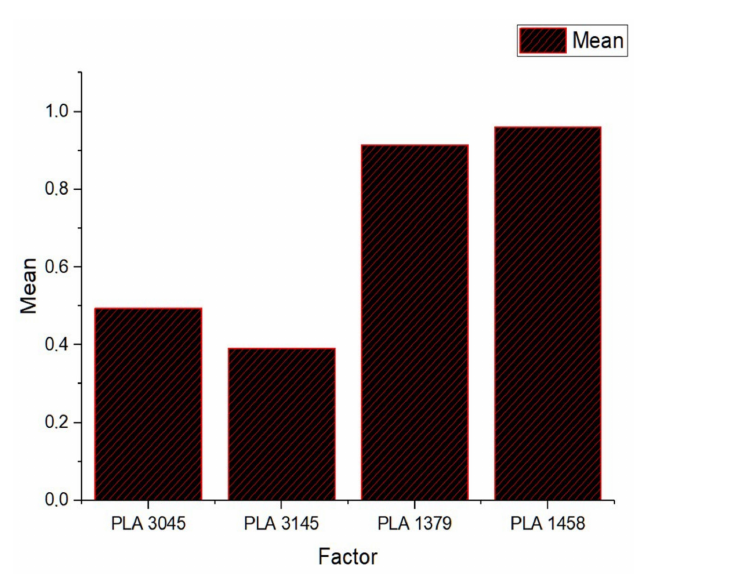
Figure 8. Bar chart.